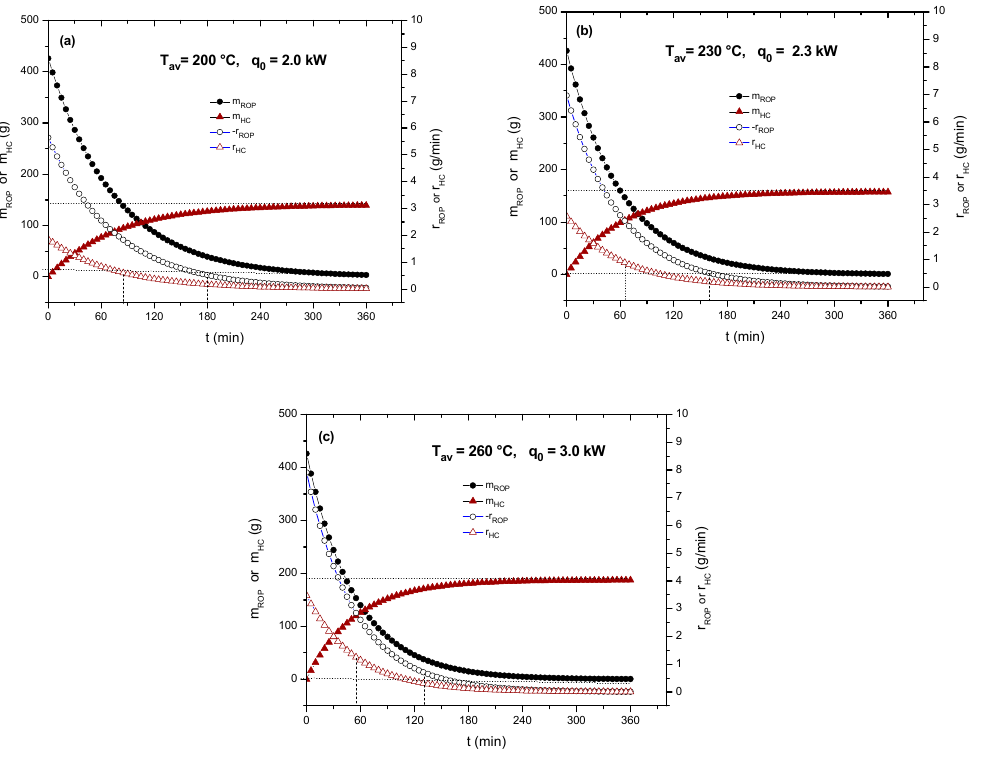
Figure 14. Temporal evolution of solid mass conversion of the raw olive pomace inside the batch reactor, ( a ): ( T (cid:2911)(cid:2932) = 200 °C and q (cid:2868) = 2.0 kW ); ( b ): ( T (cid:2911)(cid:2932) = 230 °C and q (cid:2868) = 2.3 kW ); ( c ): ( T (cid:2911)(cid:2932) = 260 °C and q (cid:2868) = 3.0 kW ).